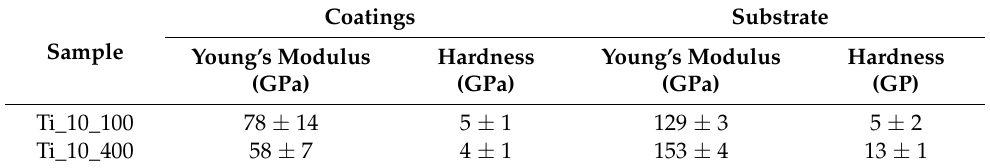
Table 6. Young’s modulus and hardness of ceramic coatings and metal